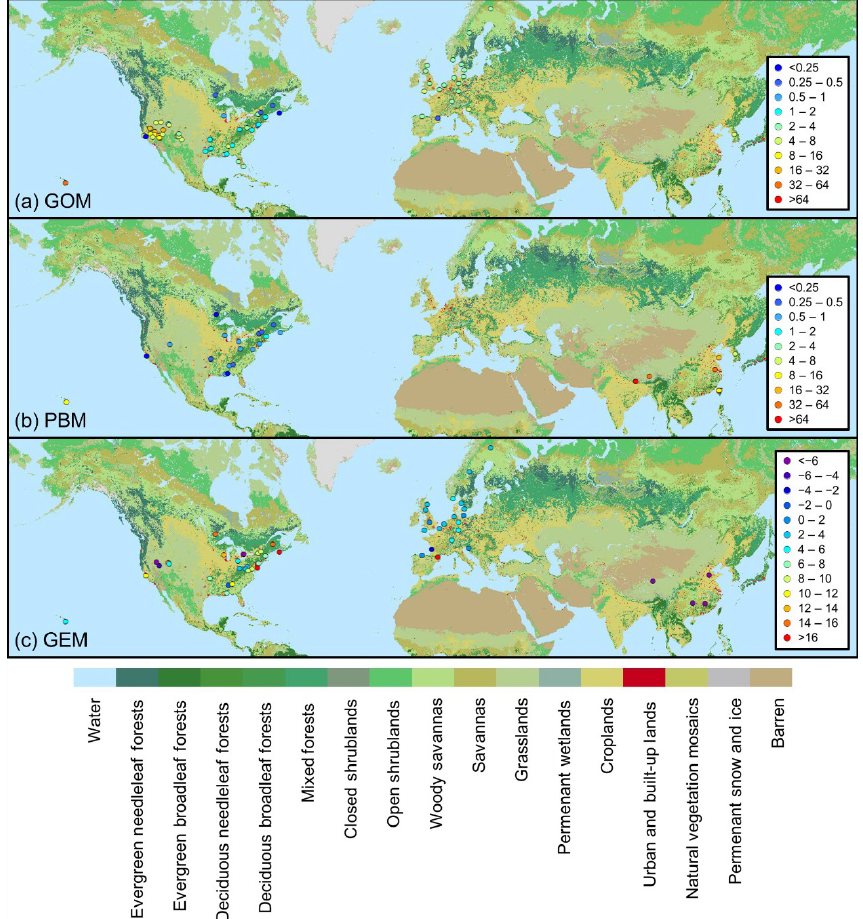
Figure 2. Global distribution of the (a) GOM, (b) PBM, and (c) GEM dry deposition fluxes (µgm − 2 yr − 1 ) from observation-based estima-